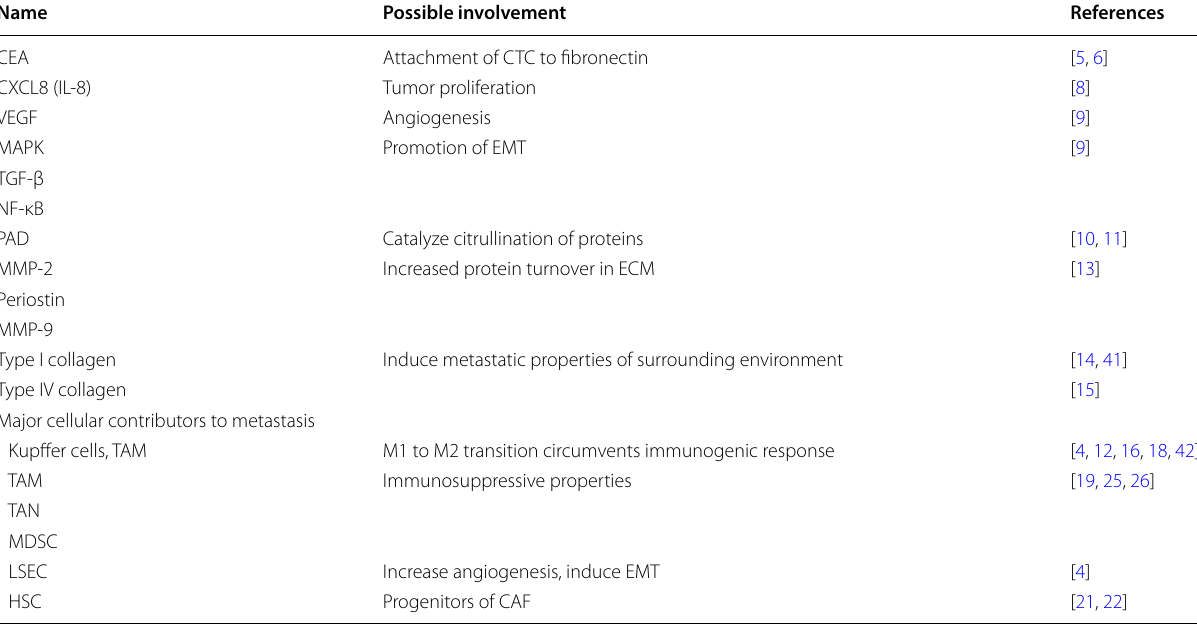
Table 1 Major acellular contributors to